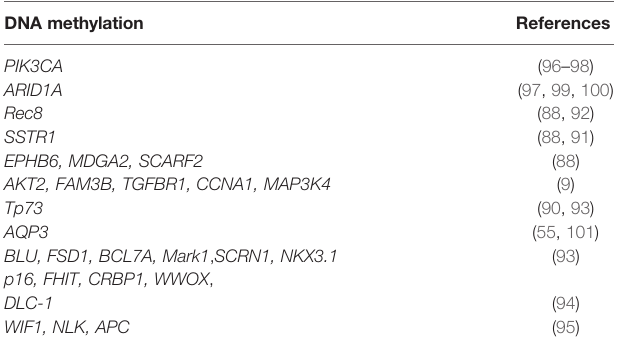
TABLE 3 | Summary of methylated genes in gastric cancer. DNA